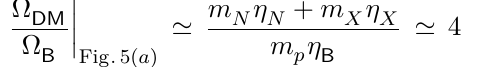
< 1 in the a SIMP model, N , and λ as in figure Z 0 XS